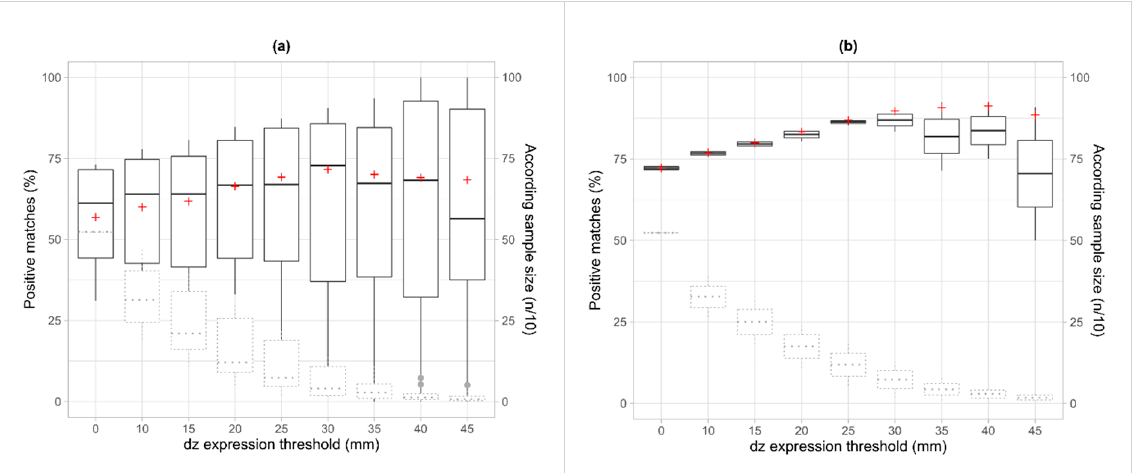
Figure 6. Development of positive matches (solid line box) and remaining sample size between the ultrasound sensor data and the TLS data, when setting filters on a dz value and ( a ) excluding horizontally aligned sensor pairs (S1_5 and S2_4) or ( b ) only considering max dz value sensor pairs (S1_3 and S3_5).